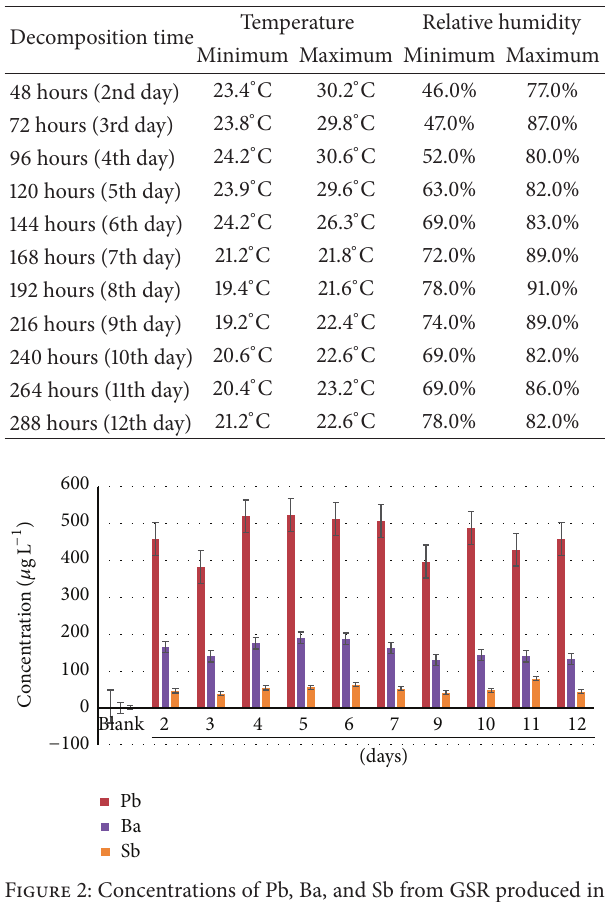
Figure 2: Concentrations of Pb, Ba, and Sb from GSR produced in larvae digests ( 𝑛 = 3 ) during the period of 2 to 12 days after the death of a female pig in